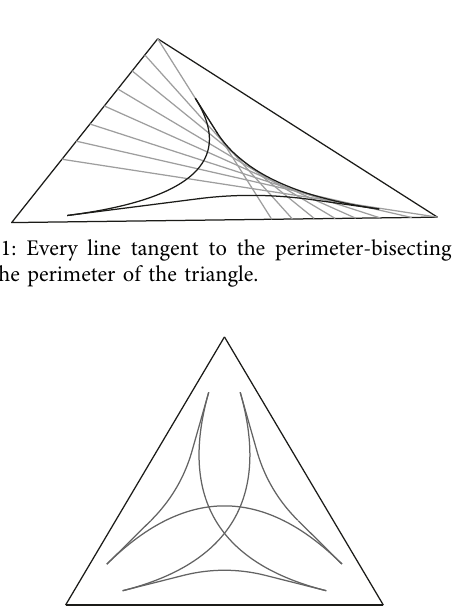
Figure 2: The envelope of all line segments that divide the pe- rimeter of an equilateral triangle into the ratio α : ( 1 − α ) , for 1/3 < α <